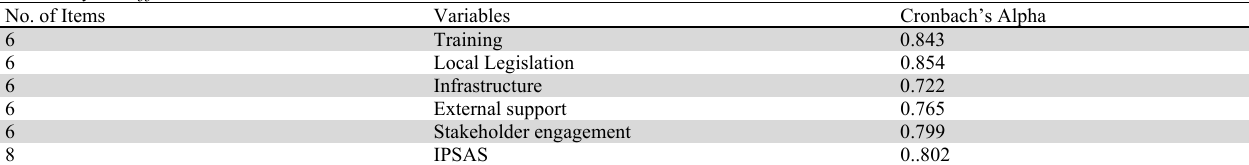
Reliability Coefficients